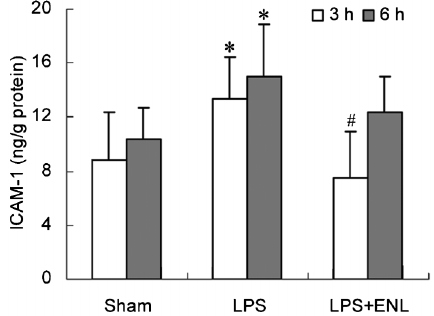
Figure 4. Effect of exogenous normal lymph (ENL) on myeloper- oxidase (MPO) activity of hepatic tissue in rats. Data are reported as means±SD (n=10). *P , 0.05 vs the sham group; # P , 0.05 vs the lipopolysaccharide (LPS) group (one-way